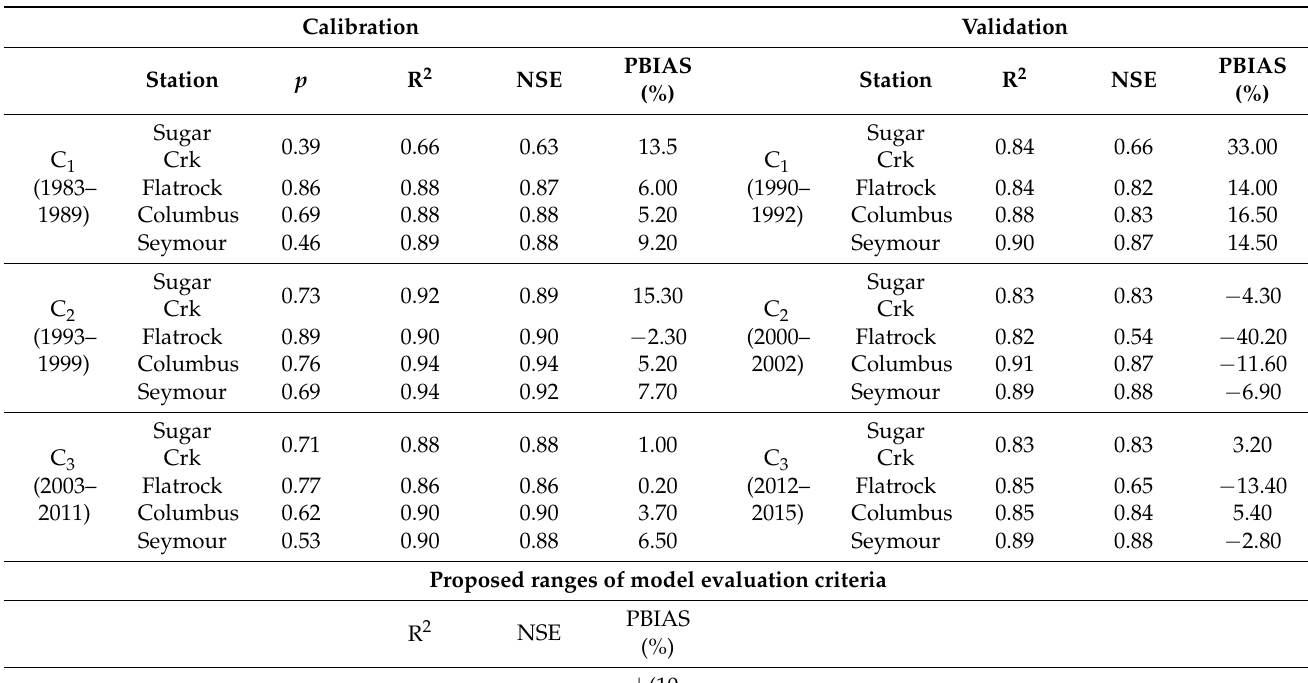
Table 3. Streamflow calibration and validation results for each of the gauging stations and the respective configuration periods.